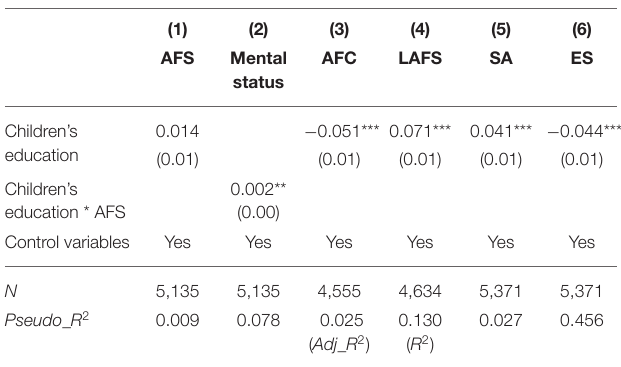
TABLE 5 | Mechanism